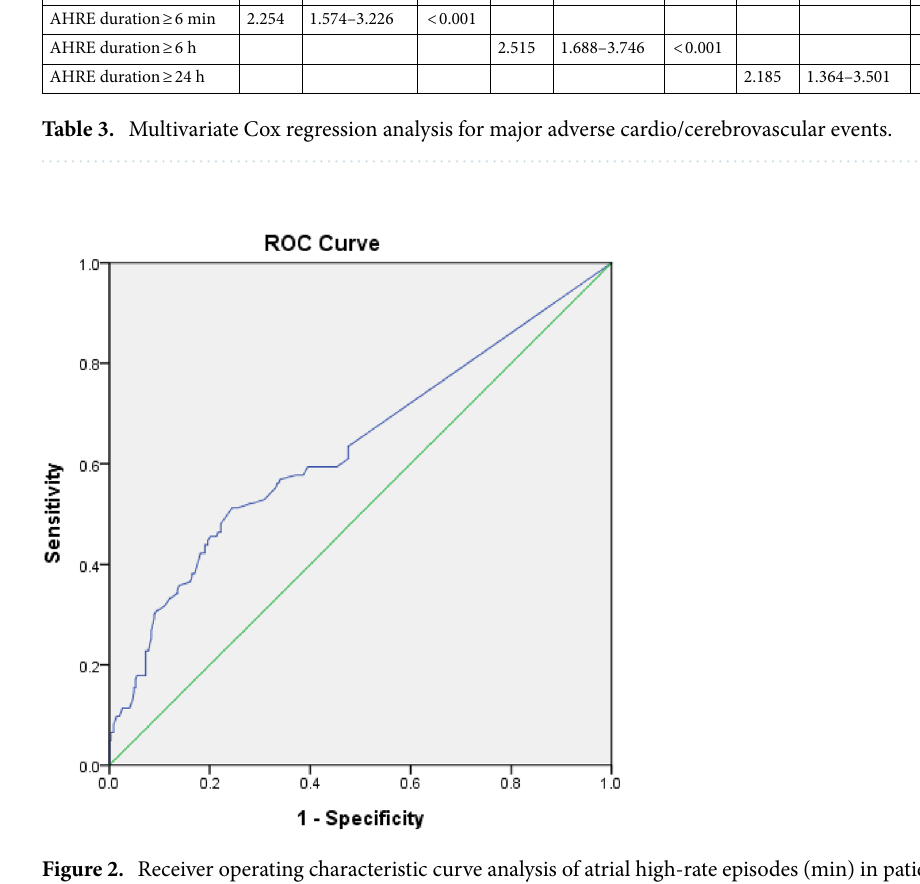
Figure 2. Receiver operating characteristic curve analysis of atrial high-rate episodes (min) in patients with CIEDs with subsequent MACCE. Atrial high-rate episodes (min): cutoff value, 6 min; sensitivity, 45.5%; specificity, 80.0%; 6 h; sensitivity, 28.0%; specificity, 91.5%; 24 h; sensitivity, 17.5%; specificity, 94.5%; area under the curve 0.633; 95% confidence intervals 0.572–0.694; p <